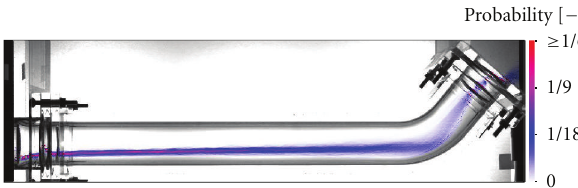
Figure 7: Visualisation of the probability distribution of the water level (colours) over the background picture (black and white)— CCFL at j L ,in = 0.25 m/s and j G =